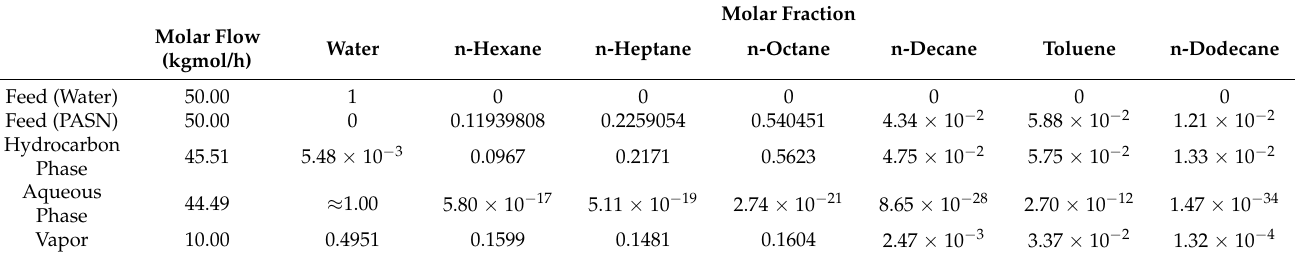
Table 6. PASN/water mixture three-phase flash calculations at T = 80 °C and P = 83.16 kPa using SRKKD model, the Rachford – Rice equations and the Python calculations of the present study.